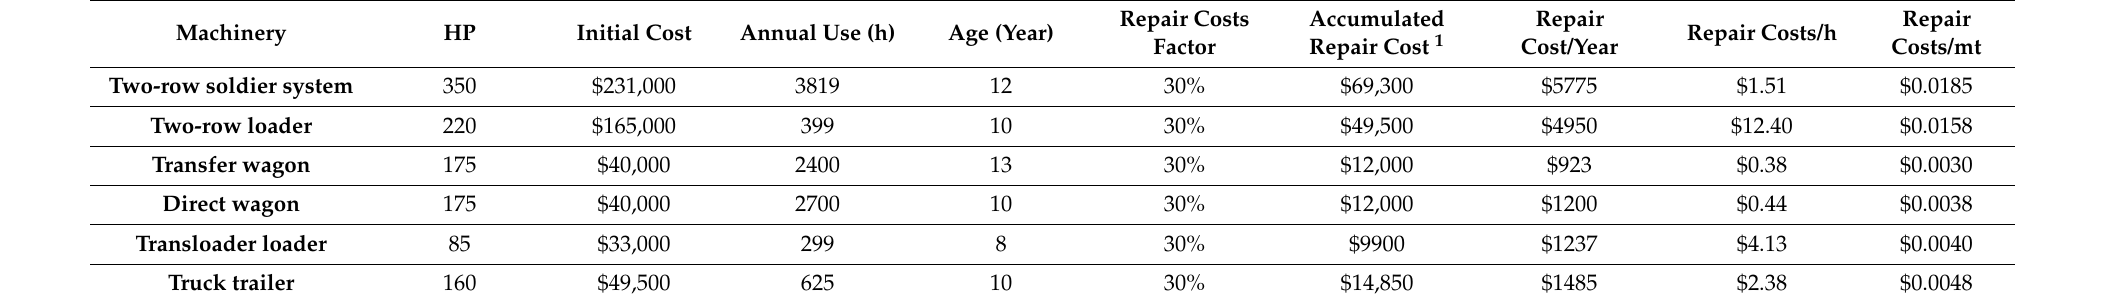
Table 6. Estimated repair costs of